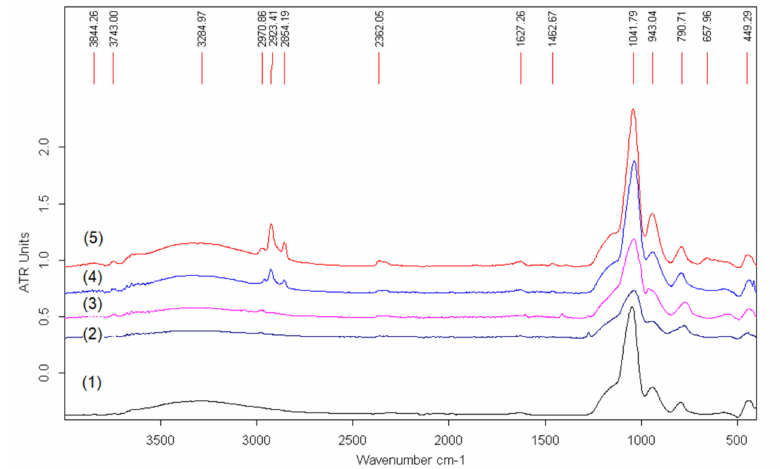
Figure 5. FTIR-ATR spectra of organo-modified silica hybrid material with various precursor compositions: ( 1 ) TEOS reference material, ( 2 ) TEOS / MTES, ( 3 ) TEOS / VTES, ( 4 ) TEOS / O 8 TES and ( 5 ) TEOS / O 18